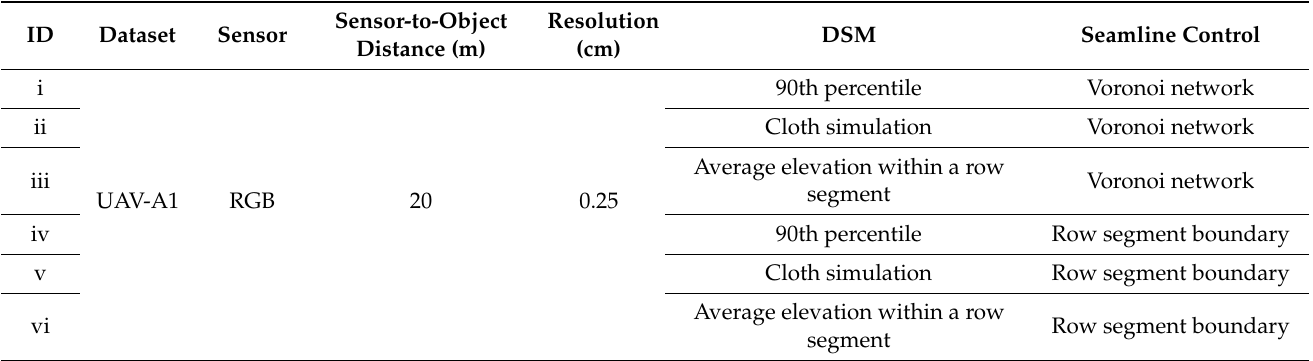
Table 2. Experimental setup of the system, sensor, sensor-to-object distance, resolution, DSM, and seamline control strategy for orthophoto i to